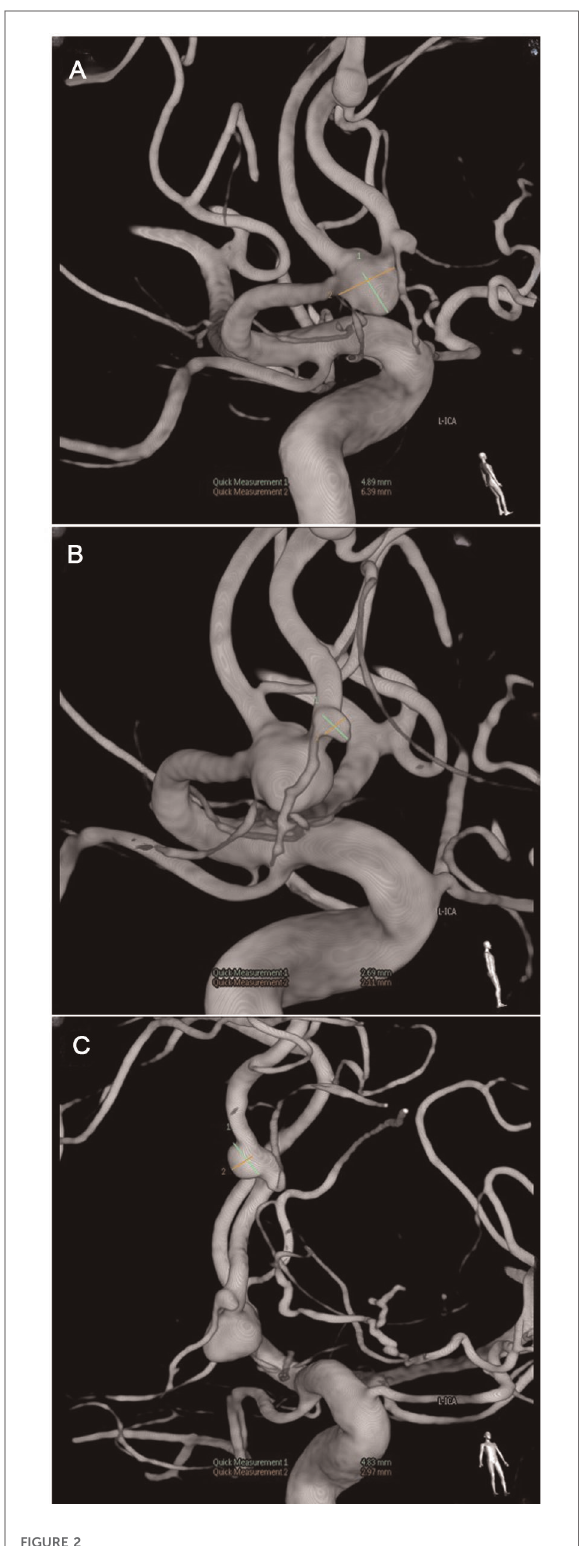
FIGURE 2 Digital subtraction angiography showing three aneurysms ’ size and